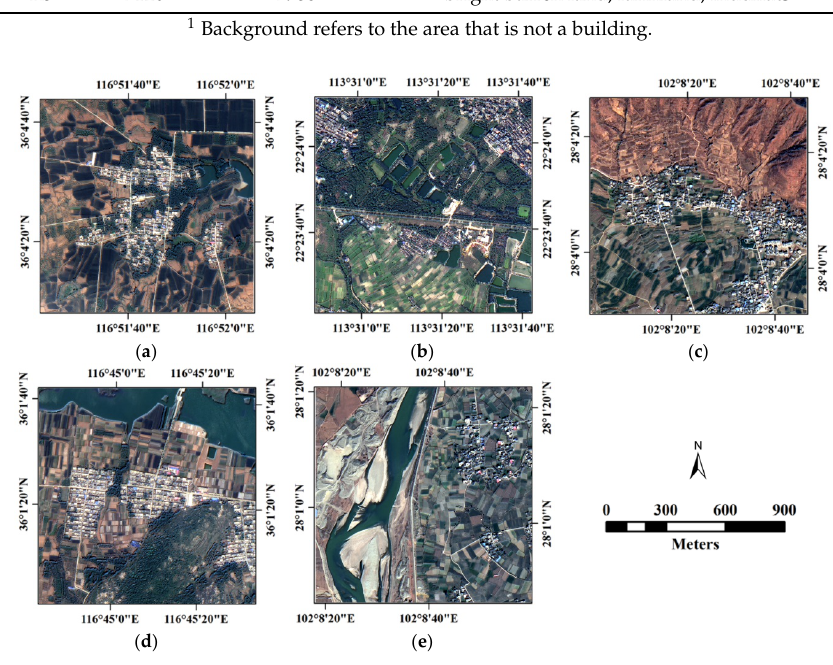
Figure 5. Five selected test image patches. ( a ) R1; ( b ) R2; ( c ) R3; ( d ) R4; ( e )